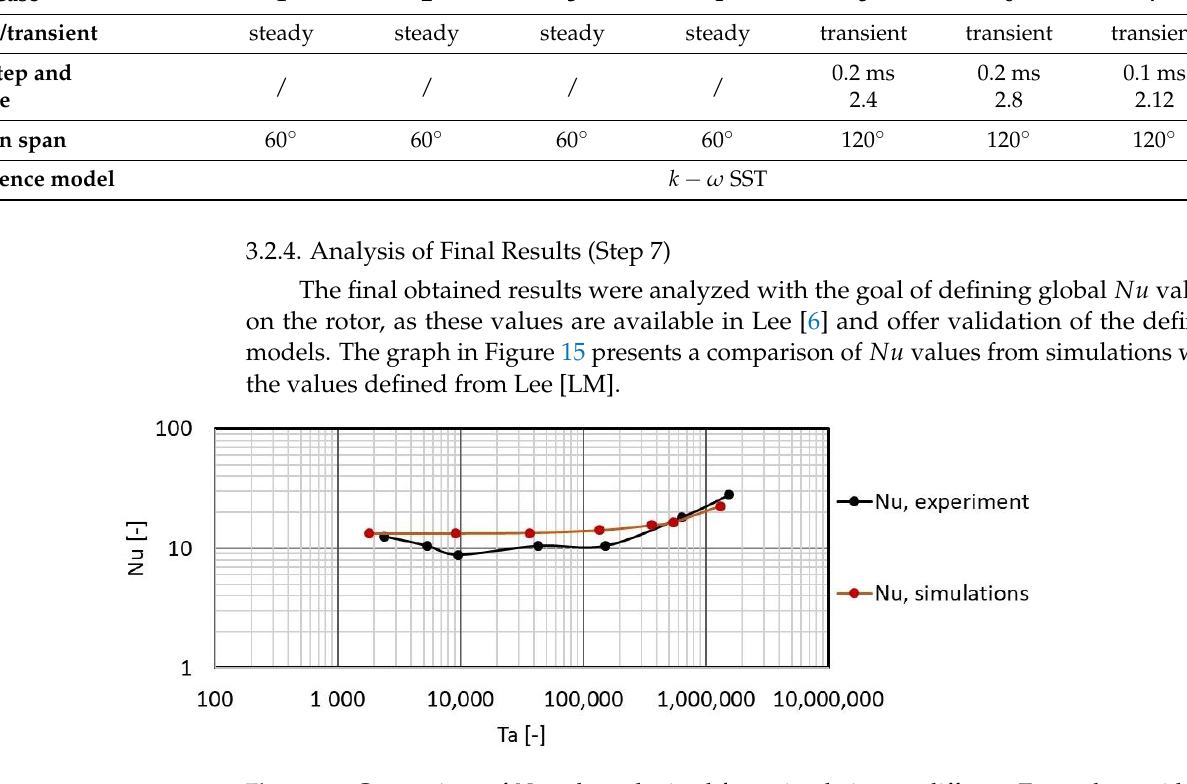
Figure 15. Comparison of 𝑁𝑢 values obtained from simulations at different 𝑇𝑎 numbers with 𝑁𝑢 values from experimental measurements presented in Lee [6].